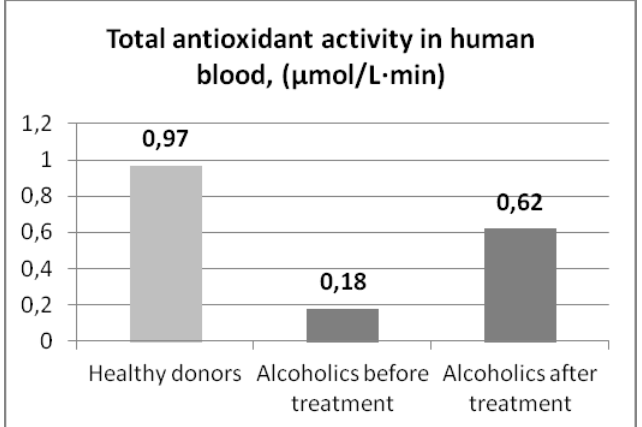
Figure 3. Total antioxidant activity of serum blood (patients with